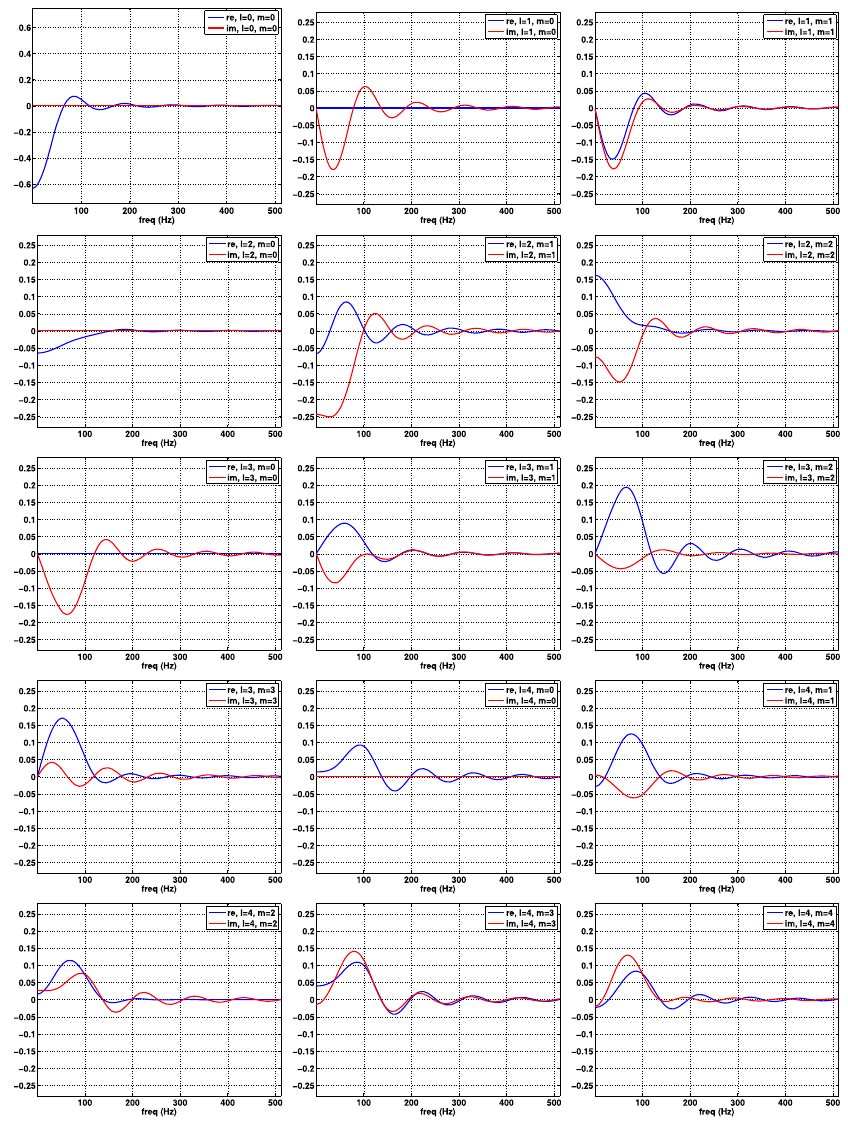
Fig. 45 Real and imaginary parts of the spherical harmonic components γ lm ( 0 ; f ) for the LIGO Hanford– LIGO Livingston detector pair. Here we show plots for l = 0, 1, 2, 3, 4 and m ≥ 0. For m < 0, use (7.14)